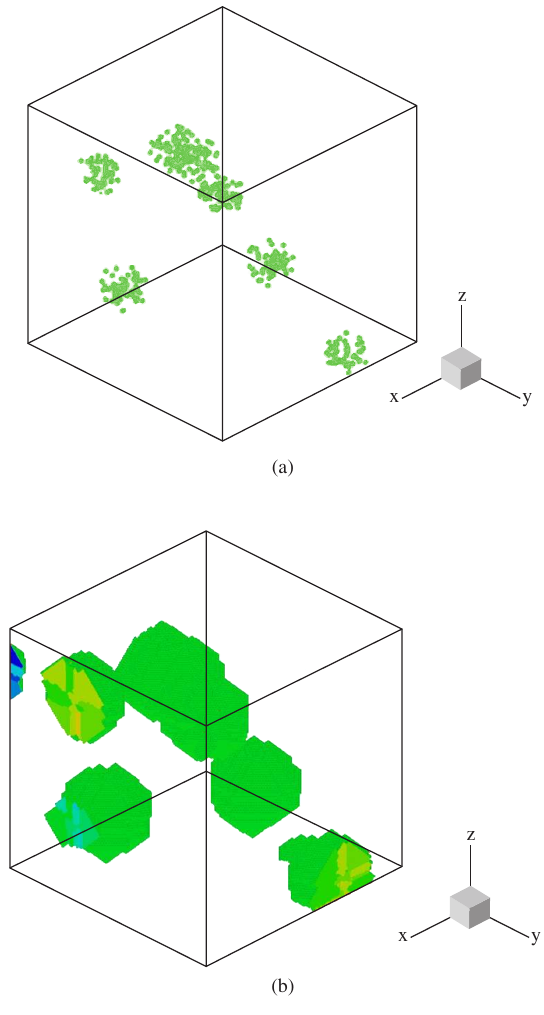
Figure 1. Simulated microstructure for randomly located nuclei: a) t = 0 and b) volume fraction equal to 0.1. Only part of the 304 x 304 x 304 matrix is shown to avoid overloading the figure.